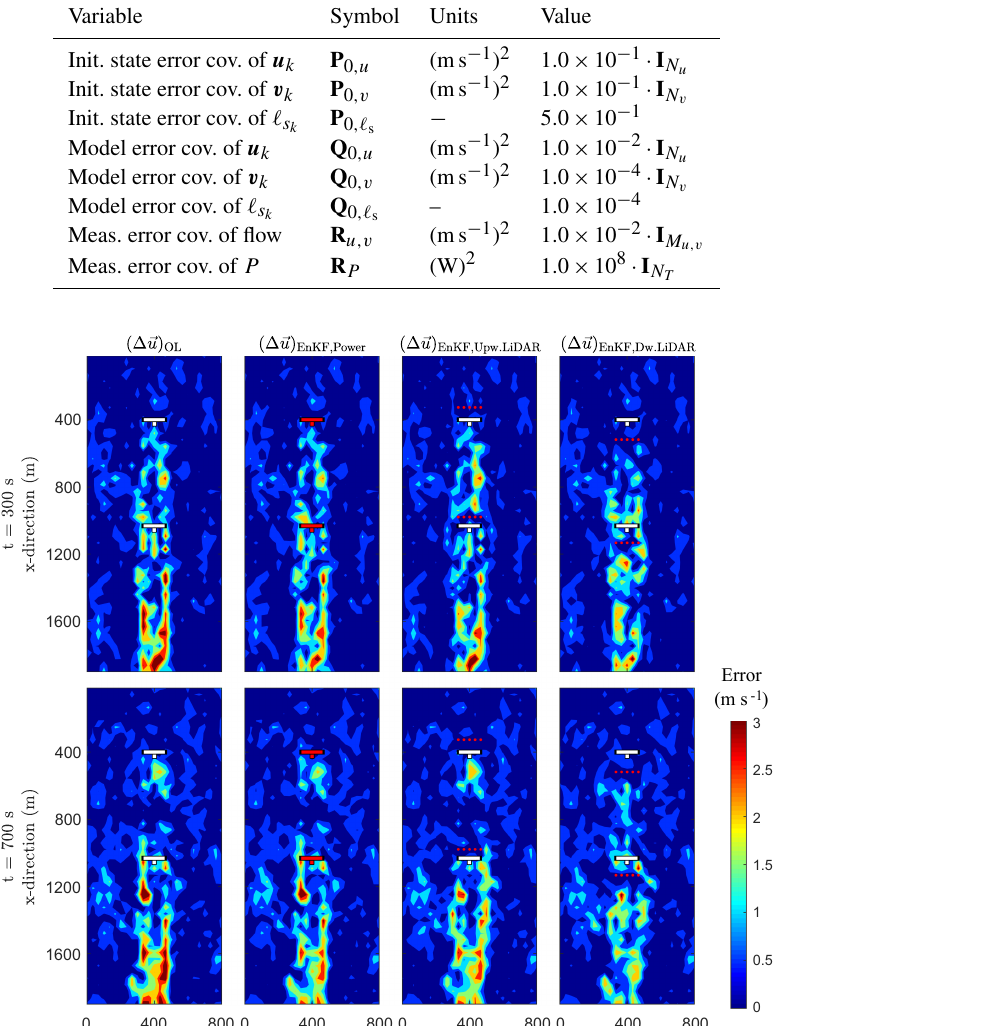
(cid:113) (cid:113) × identity matrix. The full cov. matrices are diagonal concatenations of the (cid:1) for state-only and state-parameter estimation, respectively. s